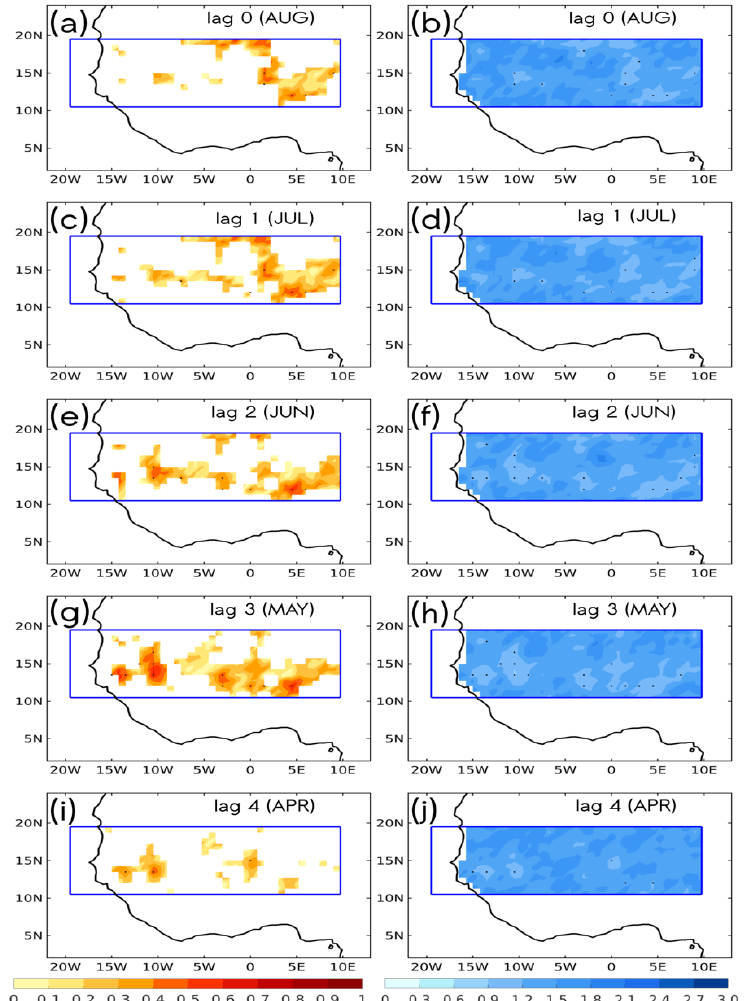
Figure 4. As in Figure 2 but for the Niño 3.4 region (170°–120° W; 6° S–6° N) that is considered for MCA, and also only the RMSE from the standardized fields are represented. ( a – b ) AUG (lag 0), ( c – d )